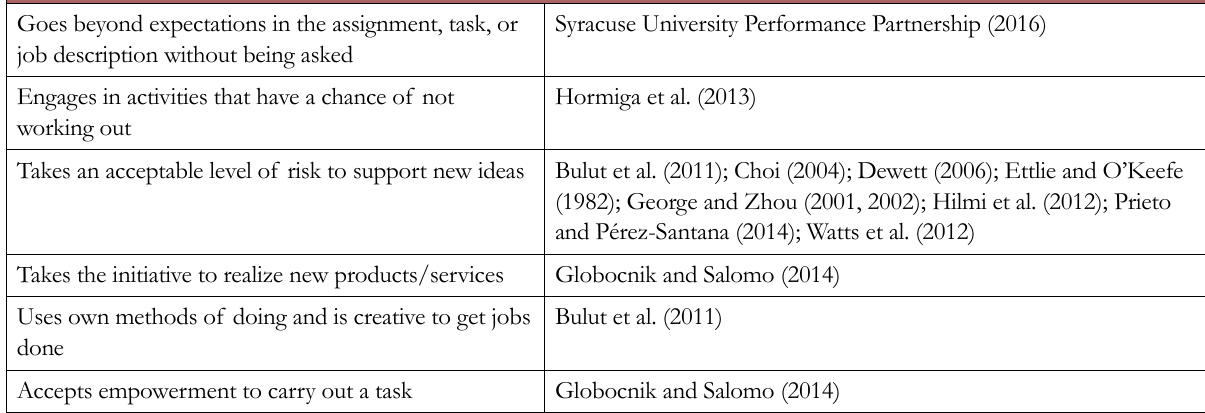
Table 16. Behaviours showing “assuming no common tasks and acceptable